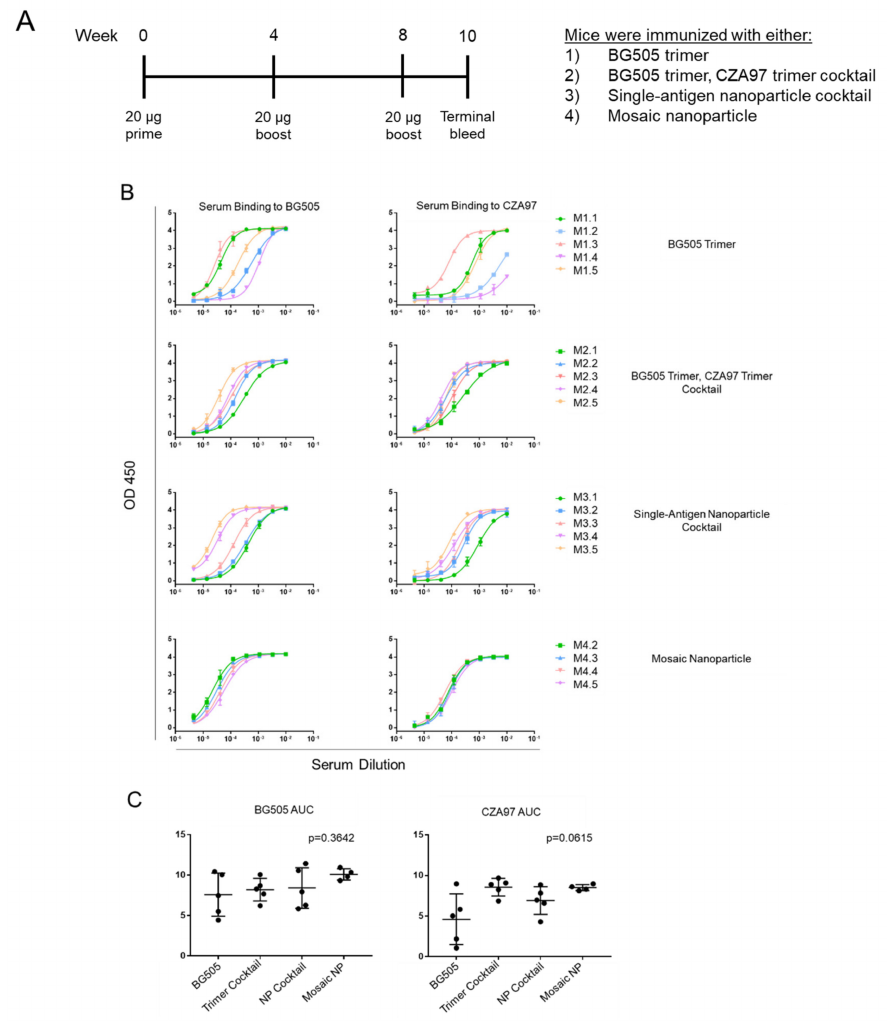
Figure 2. Nanoparticle immunogens elicit strong antibody responses in mice. ( A ). Mouse immuniza- tion scheme. Mice ( n = 5) were primed at week zero and boosted every four weeks. Terminal bleeds were performed two weeks after the second (final) boost. ( B ). Mice ( n = 5) were immunized with one of the following: BG505 trimer (M1.1–1.5), cocktail of BG505 and CZA97 trimers (M2.1–2.5),